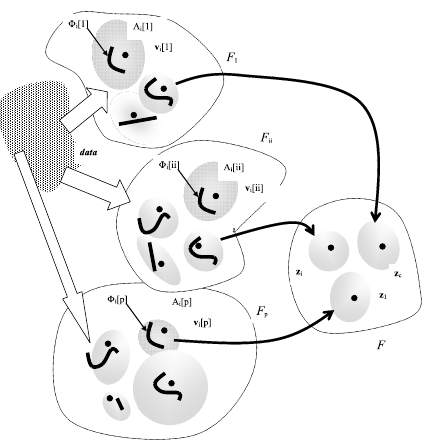
Figure 3. Hierarchical and multifaceted knowledge aggregation through selection of information